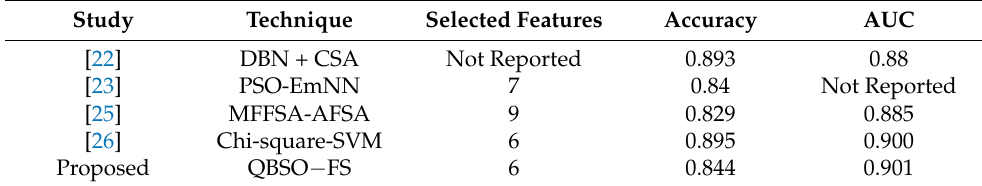
Table 9. Proposed model comparative analysis with the current state-of-the-art methods using the Cleveland dataset.